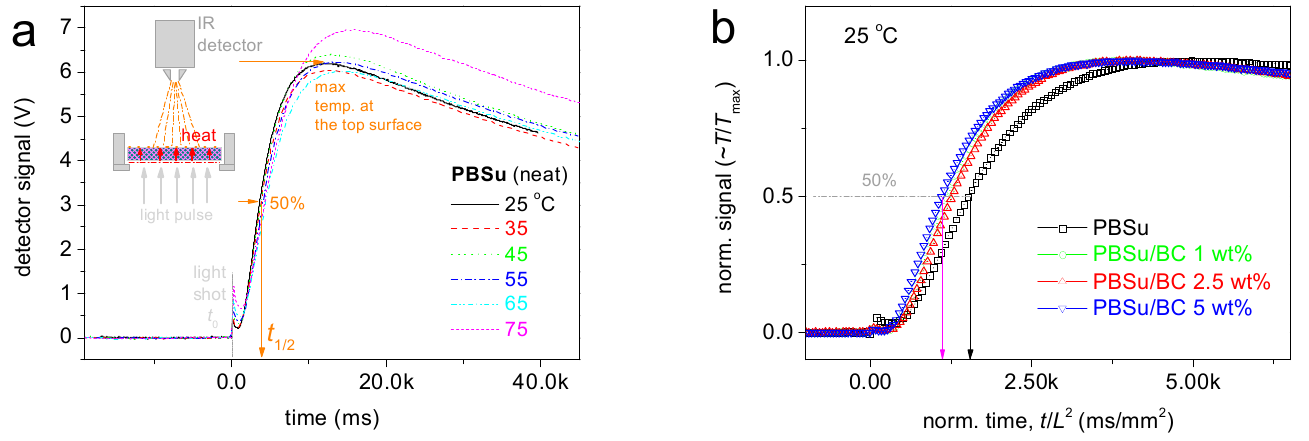
Figure 6. ( a ) Typical LFA measurements for neat PBSu at various temperatures. The added arrows describe the route for estimation of t 1/2 (to be used for the calculation of thermal diffusivity). ( b ) Comparative LFA results for all samples at 25 °C, in terms of (vertical axis) normalized signal, namely, signal/signal max, corresponding to T/T max at the top of the sample surface, and (horizontal axis) normalized time, i.e., t/L 2 , where L is the sample thickness.